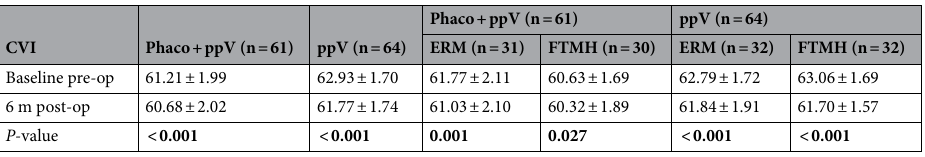
Table 3. Choroidal vascularity index (%) at 6 months post-op. Data are expressed as mean ± standard deviation (95% confidence interval). Paired t-test analysis. Statistically significant P -values are highlighted as bold. Abbreviations: ERM, epiretinal membrane; FTMH, full thickness macular hole; Phaco, phacoemulsification; ppV, pars plana vitrectomy.